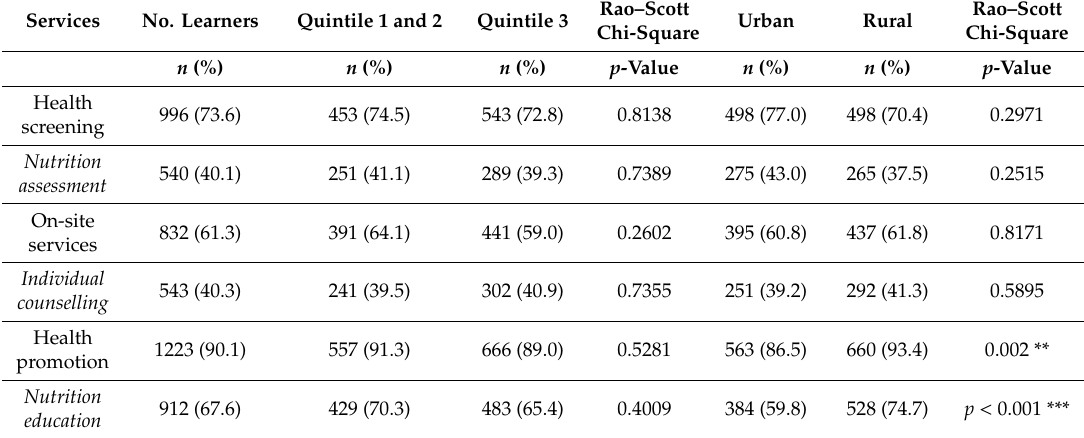
Table 7. Implementation of key health services packages at schools, according to the